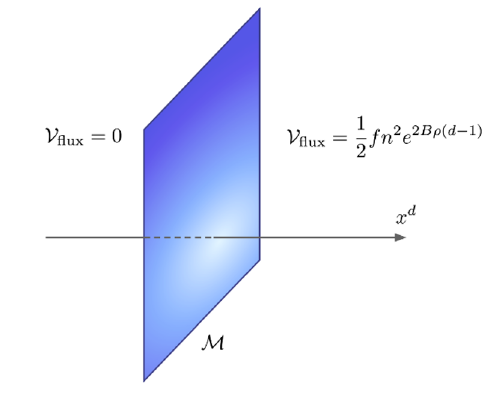
Figure 6 . A membrane that interpolates between a con(cid:12)guration with null potential and one with potential V = V (cid:13)ux